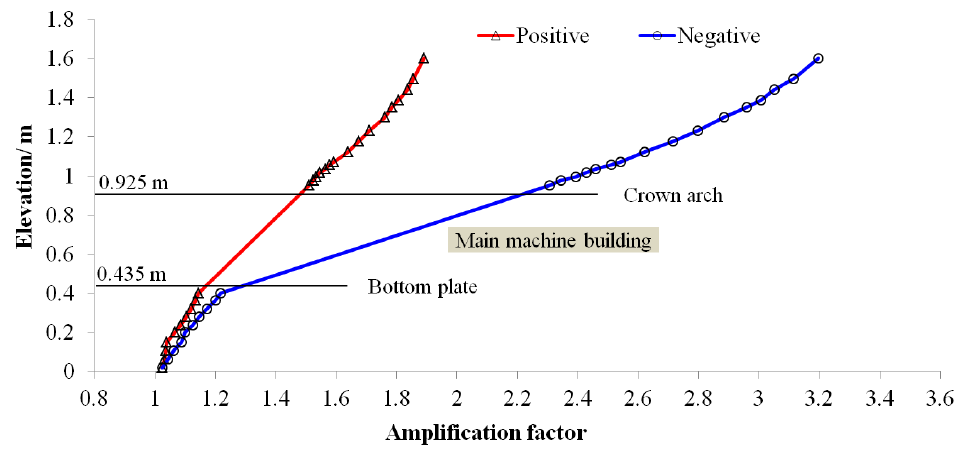
Figure 14. Amplification factor of responded acceleration at each measured point along the eleva- tion.